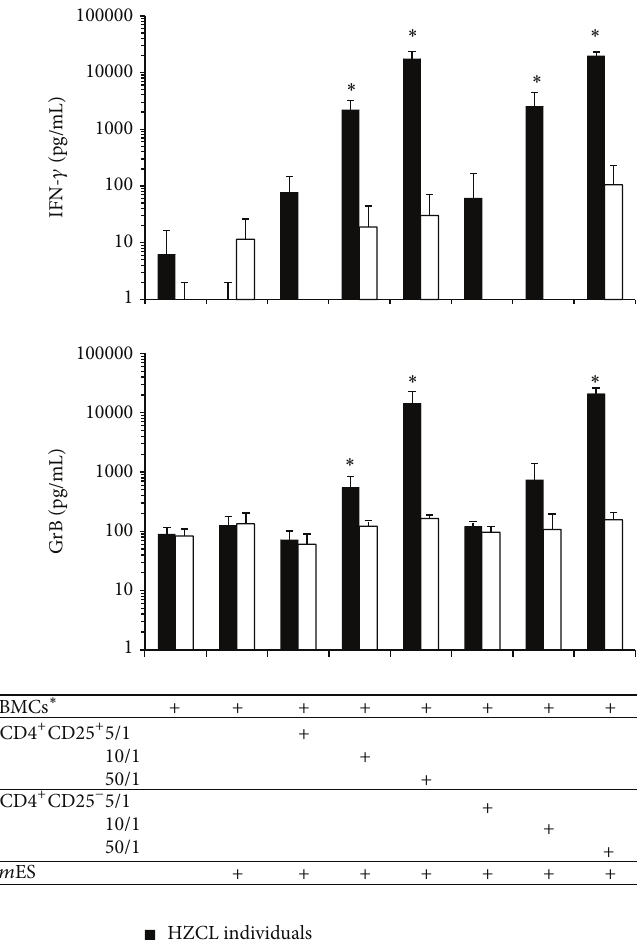
Figure 5: Both CD4 + CD25 + and CD4 + CD25 − T cell subsets produce IFN- 𝛾 and GrB in response to Lm ES in vitro . T cell subsets CD4 + CD25 +